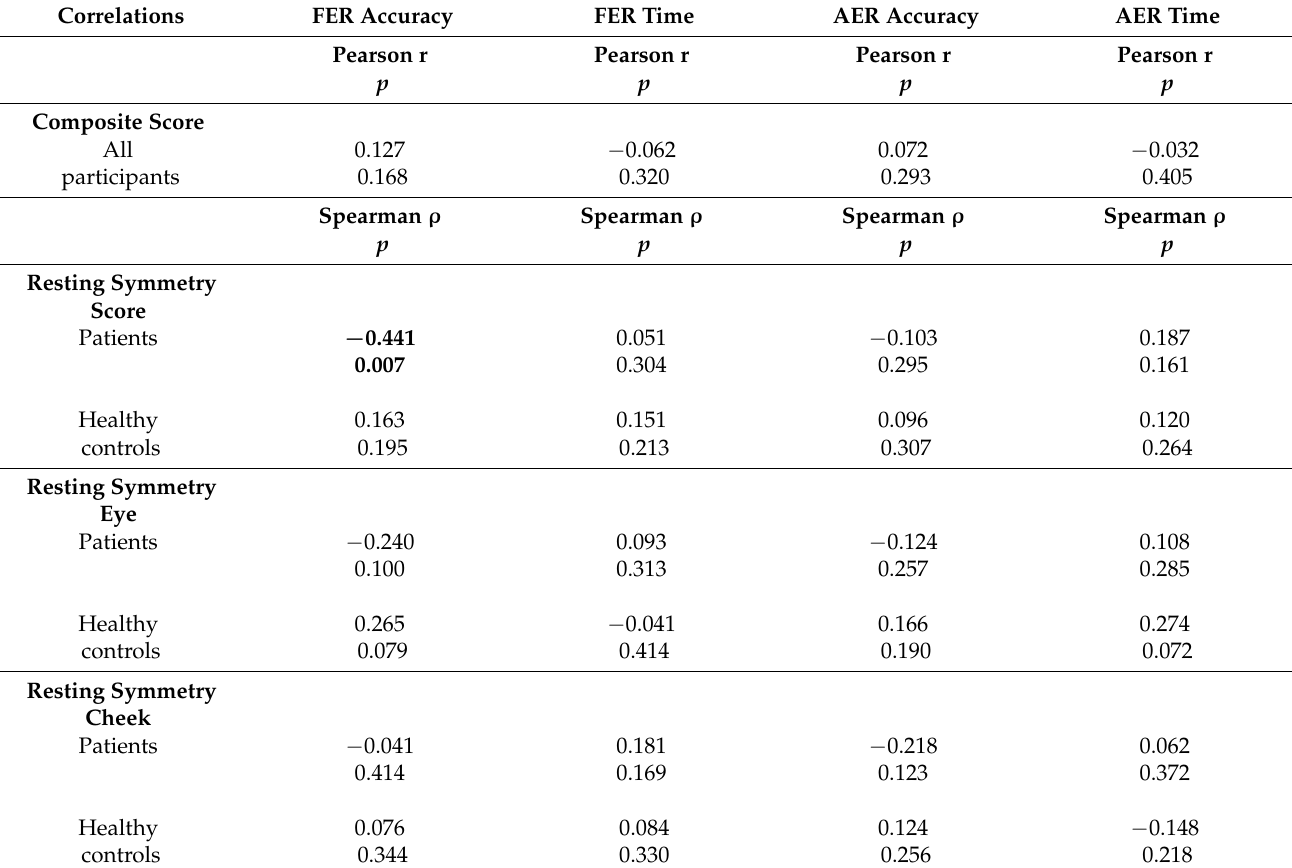
Table 4. Correlations between facial emotion recognition (FER)-accuracy/time, and auditory emotion recognition (AER)-accuracy/time, and resting facial symmetry, and facial